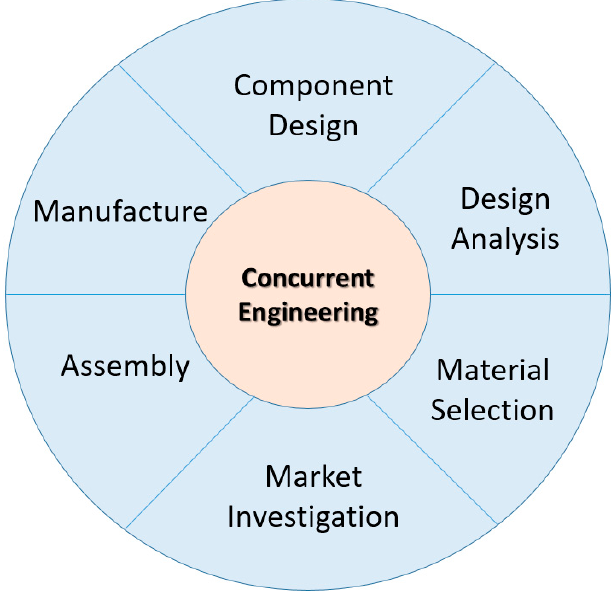
Figure 6. Concurrent engineering wheel.